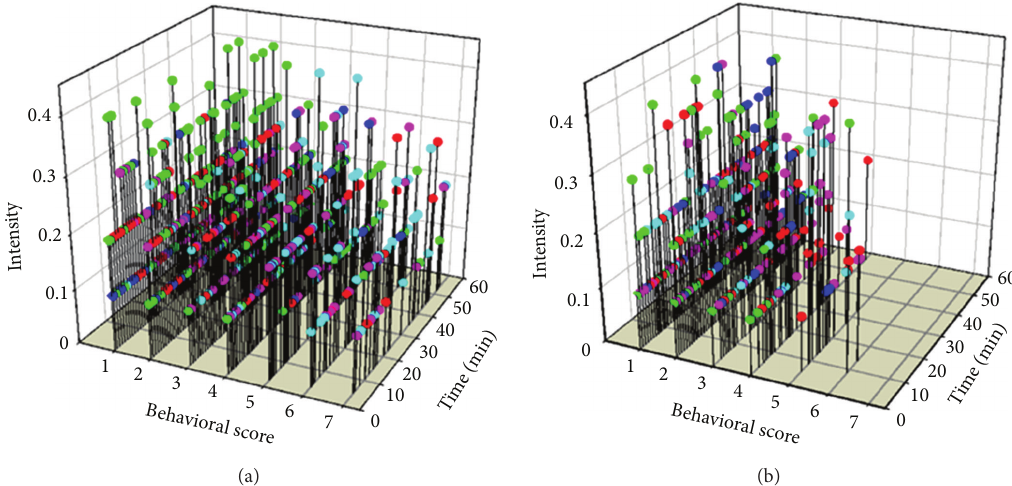
Figure 3: Comprehensive representation of social interactions for sighted crayfish in low white light (25lux). (a) In water. (b) Out of water. A single vertical line indicates a given behavior at a specific point in time as well as the intensity of the behavior. The different colored points represent individual pairs in the trials (𝑁 = 5) .